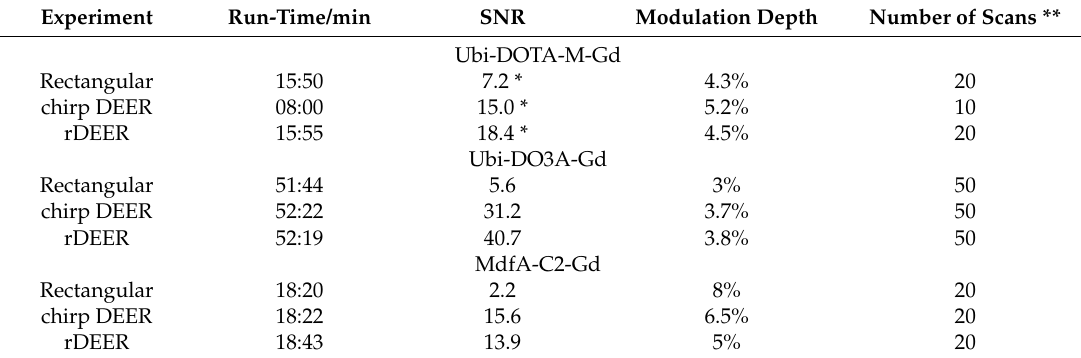
Table 1. Summary of the SNR and modulation depth obtained from the various DEER experiments on the three samples studied.